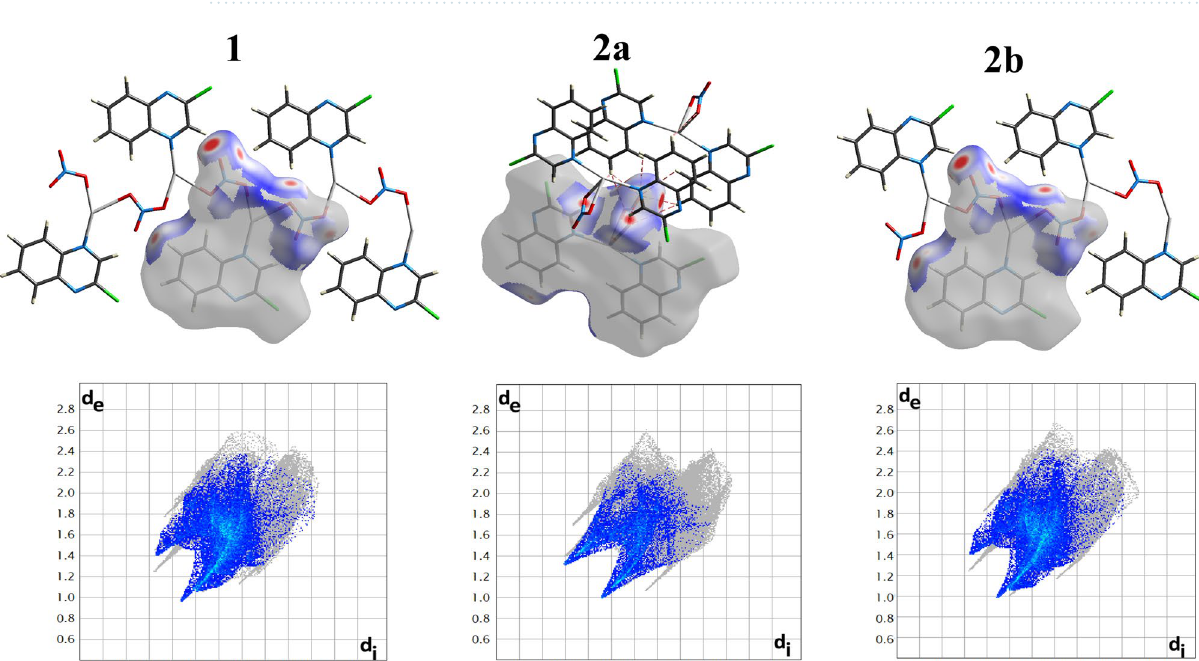
Figure 11. The d norm maps (upper) and fingerprint (lower) plots of the O…H